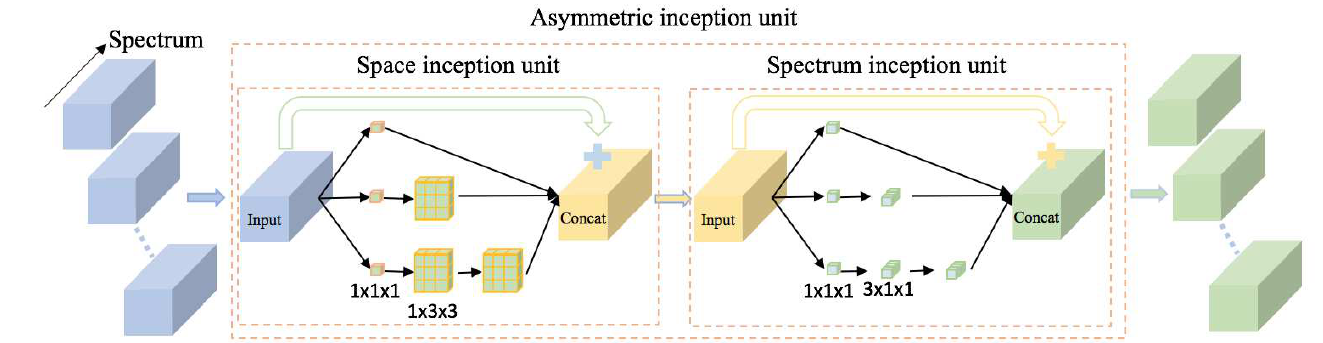
Figure 2. Illustration of an AI unit. In AI unit, 3D convolution layer is replaced with two asymmetric inception units, i.e., space inception unit and spectrum inception unit. In the space inception unit, the input cube is fed into three different paths. In path one, a pointwise convolution layer is applied. In path two, one pointwise convolution layer and one 2D convolution layer are used. In path three, one pointwise convolution layer and two 2D convolution layers are used. The outputs of each path are concatenated in channel, and are added to the output of the shortcut connection. The structure of spectrum inception unit is similar to the space inception unit, except that 1 × 3 × 3-sized convolution layers are replaced with 3 × 1 × 1-sized convolution layers in spectrum inception unit.